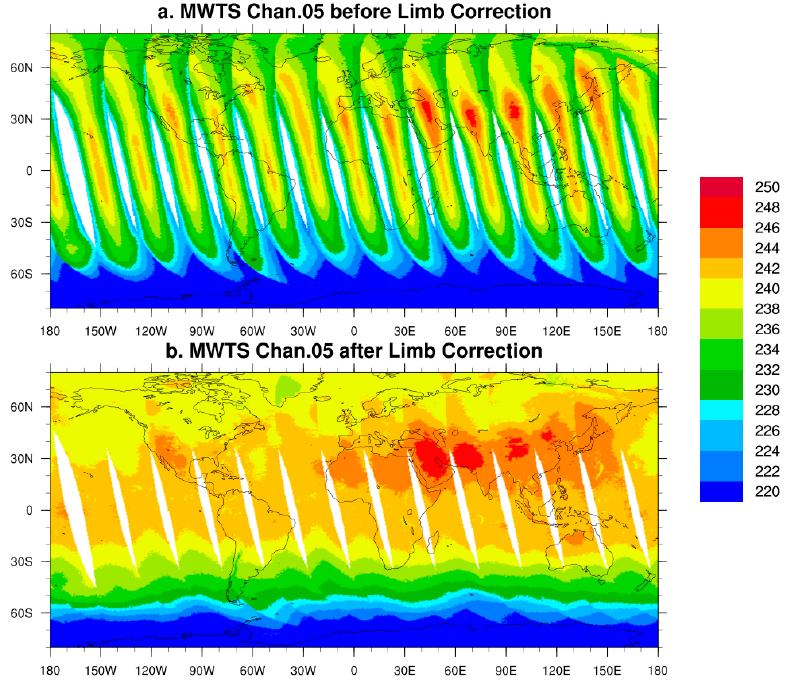
Figure 2. ( a ) Global fields of unadjusted brightness temperatures and ( b ) limb adjusted brightness temperatures for MWTS channel 5.